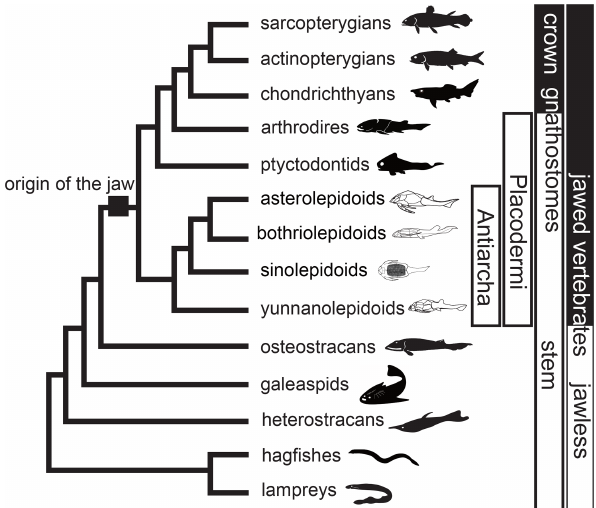
Figure 1. Phylogenetic relationships of major early vertebrate groups from Qiao et al. (2016) and Pan et al. (2018). Silhouettes indicate groups of